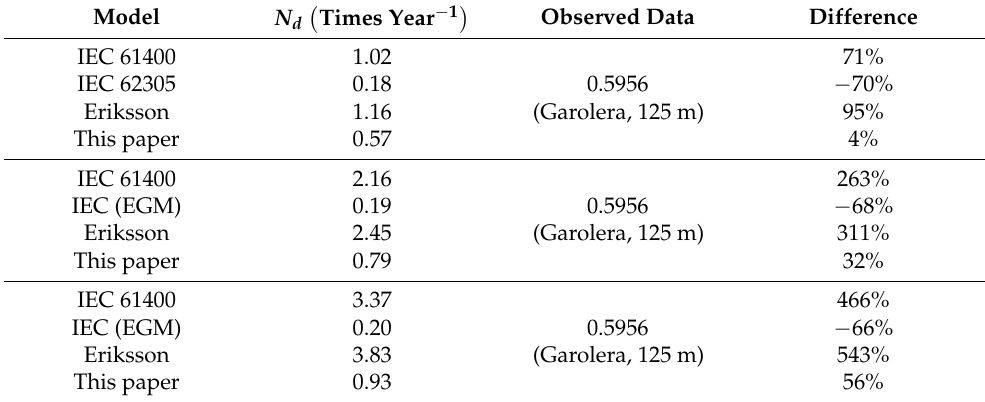
Table 4. The difference of the N d among the observed statistics and different calculation